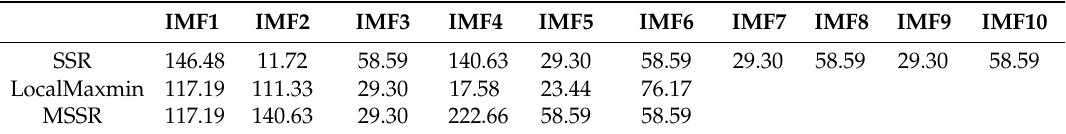
Table 5. The experimental results of roller ball of motor